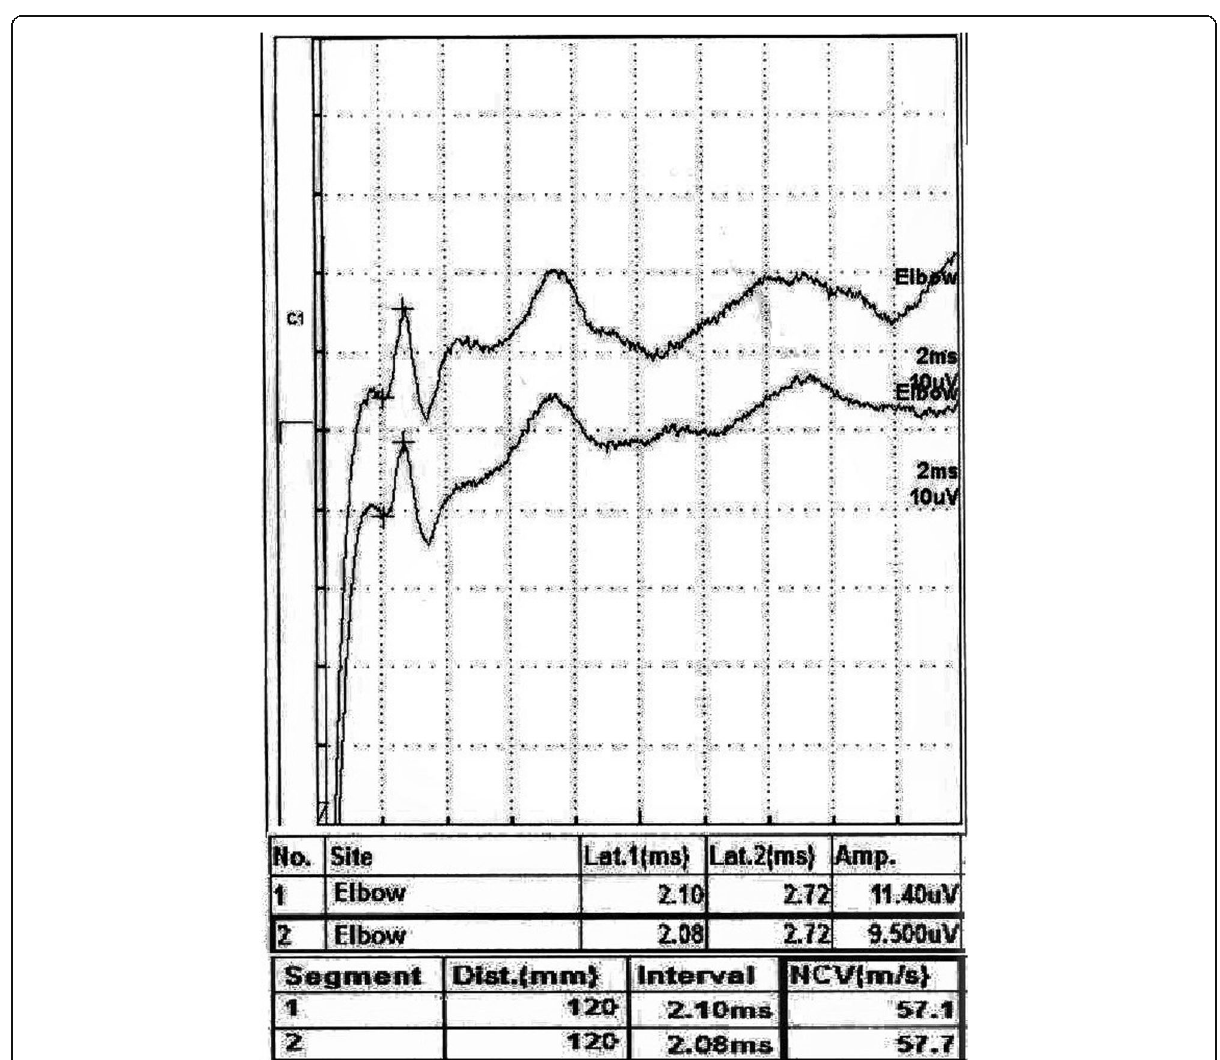
Fig. 2 Posterior antebrachial cutaneous sensory nerve action potentials (SNAP) of an apparently healthy man (the two potentials are separated from each other for proper illustration of the potentials). Each SNAP is followed by volume-conducted motor potential of the forearm extensor